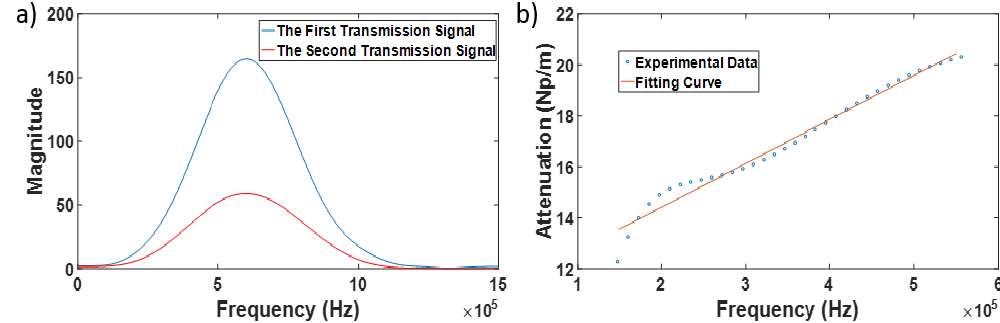
Figure 3. The attenuation measurement results with a polymethylmethacrylate material sample. ( a ) The magnitude spectrum of the first and second transmission wave after Fourier transformation; ( b ) The curve fitting based on the experimentally measured ultrasonic